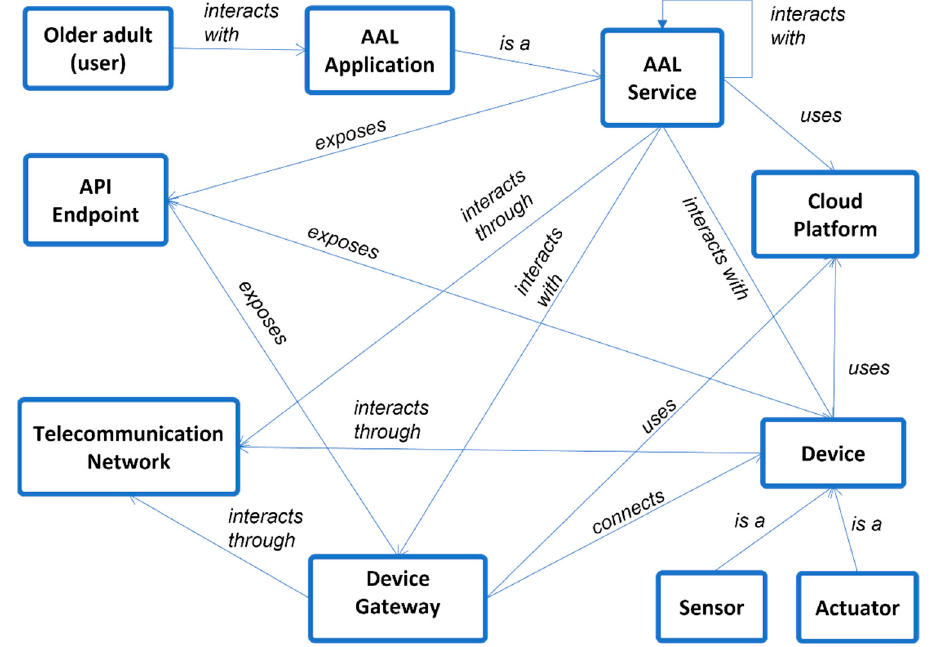
Figure 2. Pharaon and AAL conceptual model. Table 2. Pharaon and AAL concepts mapped to concepts in ISO/IEC 30141:2018.